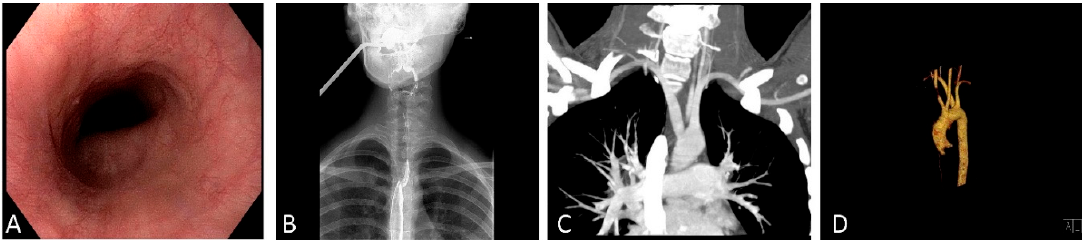
Figure 1. (A) Oesophagogastroduodenoscopy showing an image of an ab extrinseco compression of the mid-cervical oesophagus. (B) Upper gastrointestinal tract radiography confirming an oesophageal impression above the arch of the aorta. (C) Computed tomography angiography and (D) three-dimensional visualization, which detect the presence of a lusoria artery originating from the medial margin of the descending aorta and crossing the trachea and oesophagus posteriorly to the distal third, resulting in a tortuous appearance.